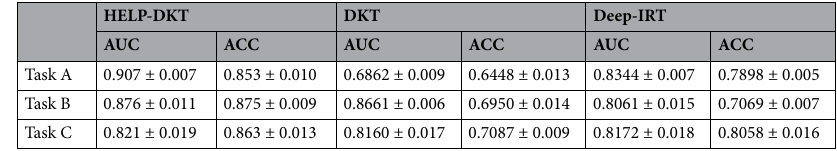
Table 2. Prediction performances of the HELP-DKT, DKT, and Deep-IRT